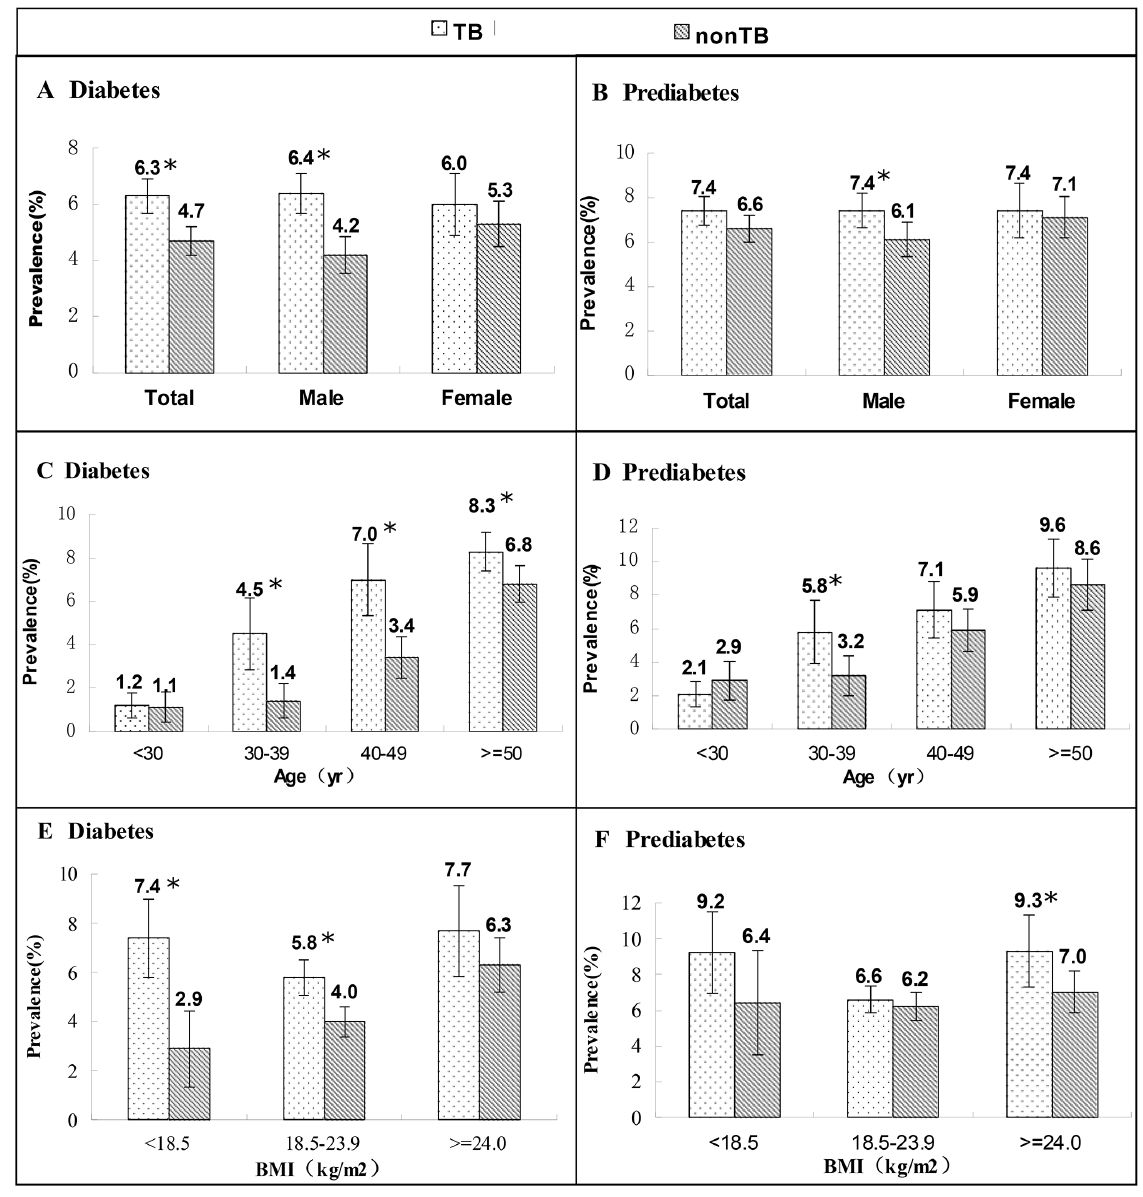
Figure 2. The prevalence of diabetes and prediabetes in TB and non-TB. The overall prevalence of diabetes and prediabetes in TB and non- TB was shown in Figure 2. Also, the sex, age ( , 30, 30 , 39, 40 , 49, $ 50) and BMI ( , 18.5, 18.5 , 23.9, $ 24.0) stratified prevalences were shown. The prevalence of diabetes in PTB patients was 6.3%, which was significantly higher than in non-TB controls (4.7%). The prevalence of diabetes increased with increasing age and was significantly higher in the TB than in the non-TB groups except for the age group , 30. Among BMI subgroups in TB patients, normal weight patients with a body mass index of 18.5–23.9 had the lowest prevalence of DM (5.8%), while the prevalence in overweight and obese cases (BMI $ 24) was the highest. TB: pulmonary tuberculosis patients, non-TB: non tuberculosis